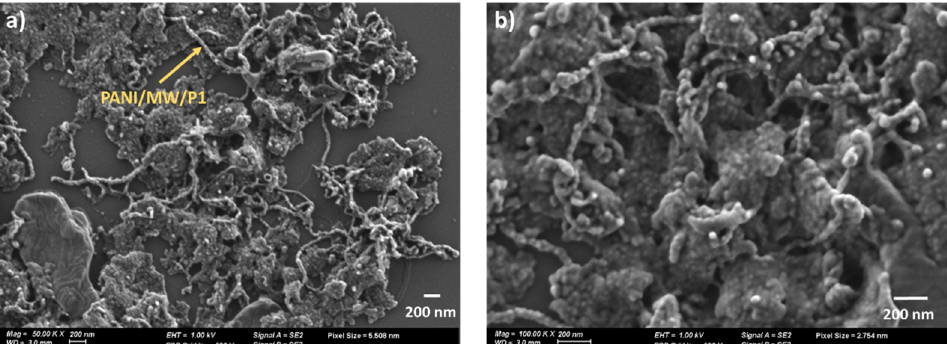
Figure 3. HR-SEM images of the PANI/MW/P1 at a magnification of ( a ) 50 and ( b ) 100